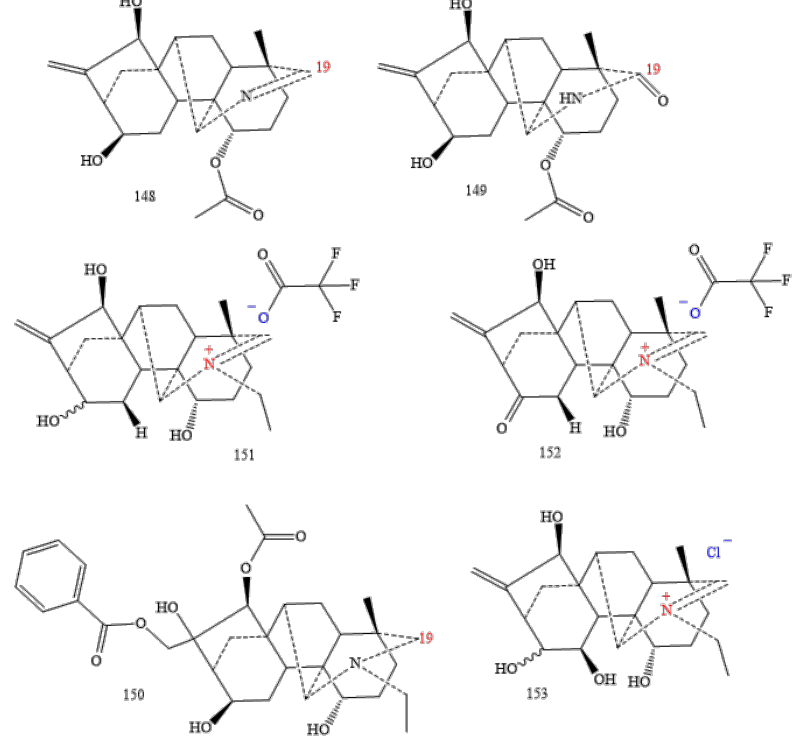
Figure 18. C 20 -napelline DAs.